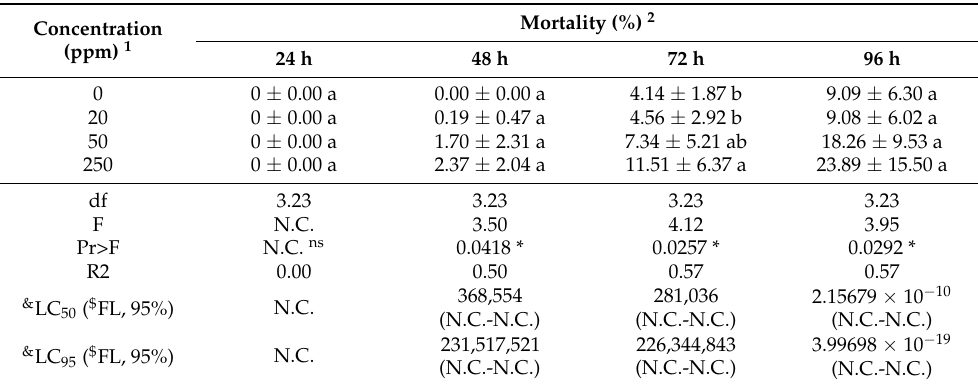
Table 7. Mortality ( ± SD) of tomato psyllid Bactericera cockerelli , at different concentrations of com- bined ZnO-TiO 2 NPs on tomato